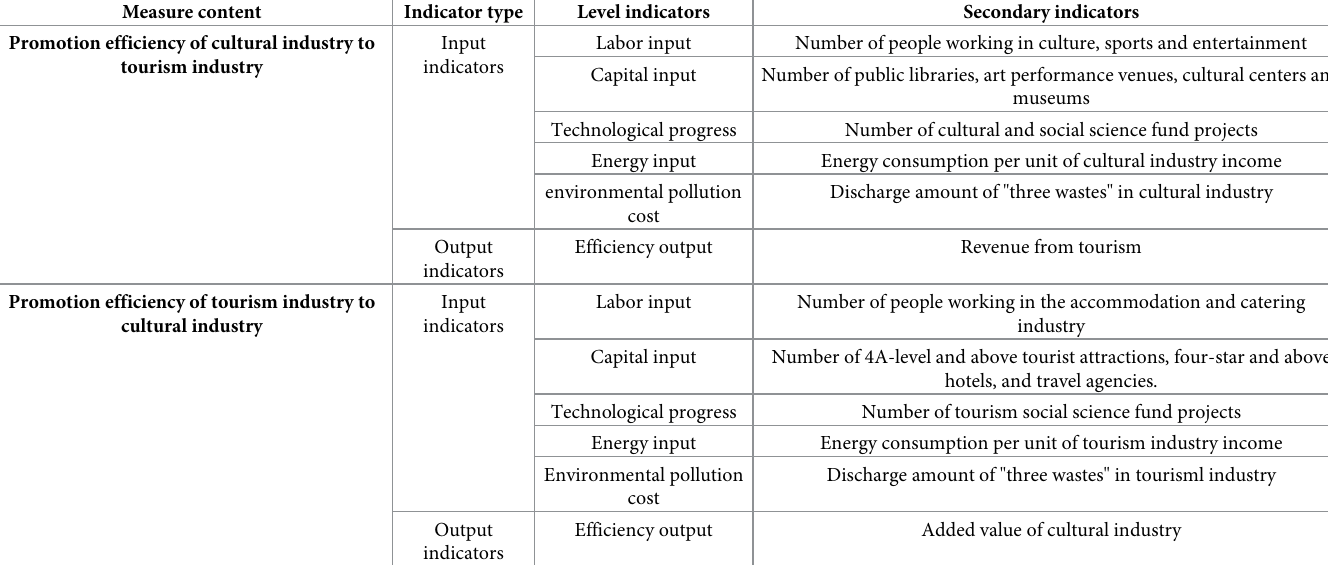
Table 1. Index system for measuring the integration efficiency of culture and tourism under high quality